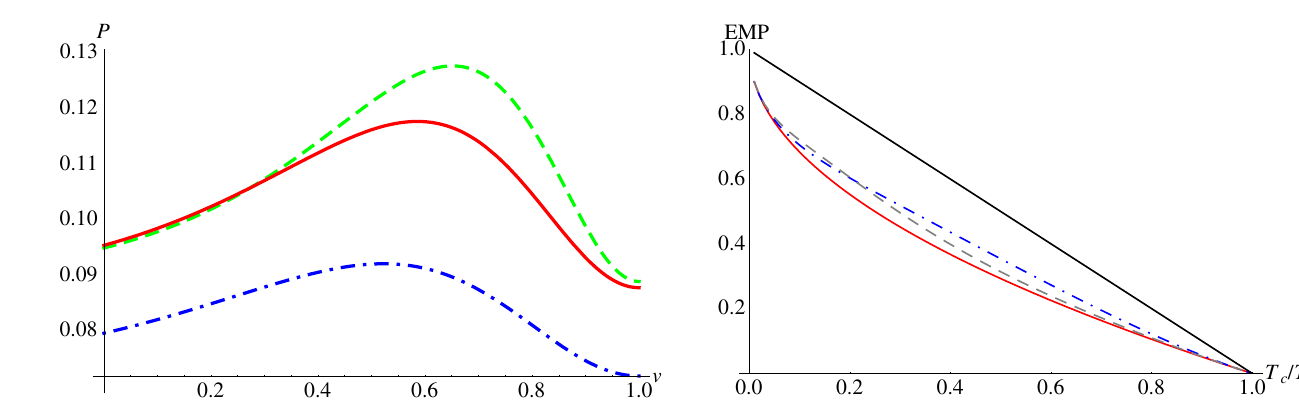
FIG. 10. Power as a function of the anyonic phase for two topological anyons at T c / T h = 0.1 (dashed, green), T c / T h = 0.2 (solid, red), and T c / T h = 0.3 (dot dashed, blue). Parame- ters are α c = α h = γ = τ c = τ h = 1, and κ = 0.5, along with (cid:2) = k = 1. B